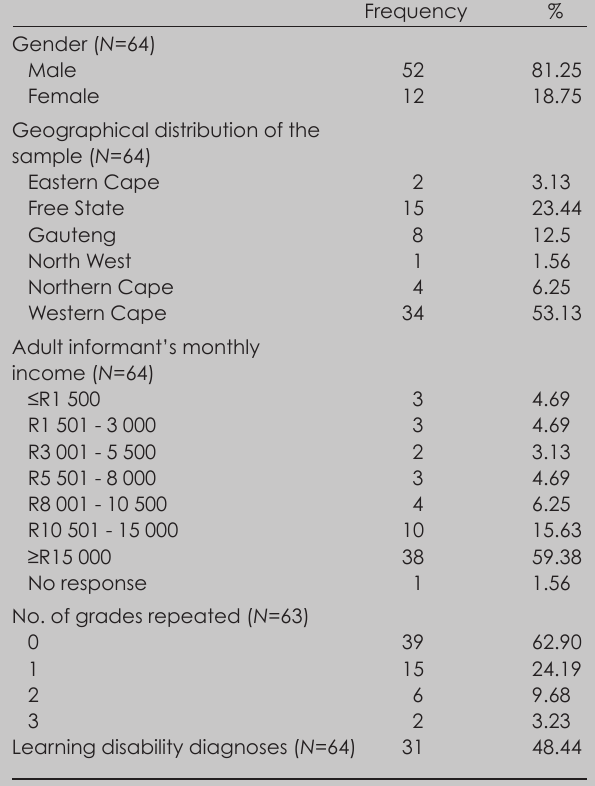
Table I. Frequency distribution for gender, geographical distri- bution, grades repeated and learning disability diagnoses